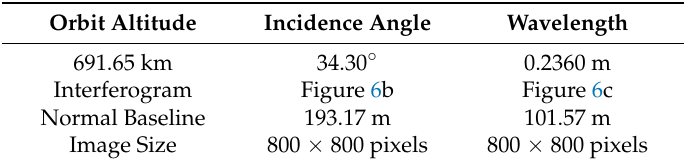
Table 2. Major parameters of the employed Advanced Land Observing Satellite (ALOS) Phased Array type L-band Synthetic Aperture Radar (PALSAR)